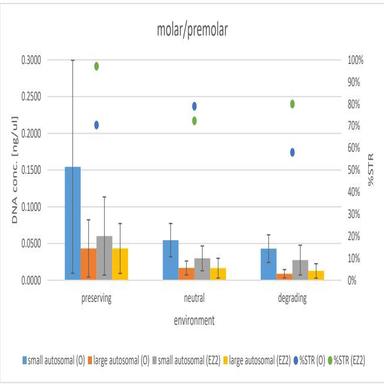
Average DNA concentration result values by the qPCR method for autosomal markers (small and large) and average amplification efficiency (% of STR markers in the profile) depending on soil conditions from which molar/premolar (n=15, 5 per environment) was obtained.